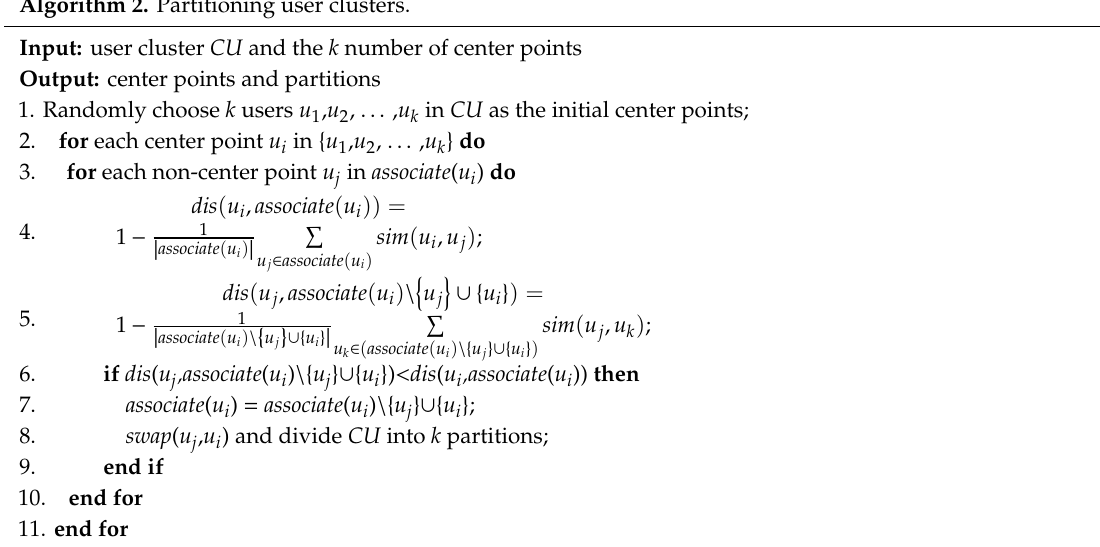
Algorithm 2. Partitioning user